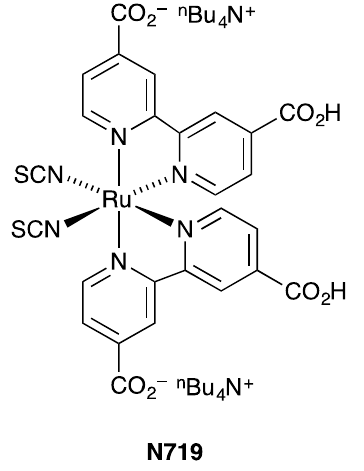
Scheme 1. Structure of the reference dye N719.